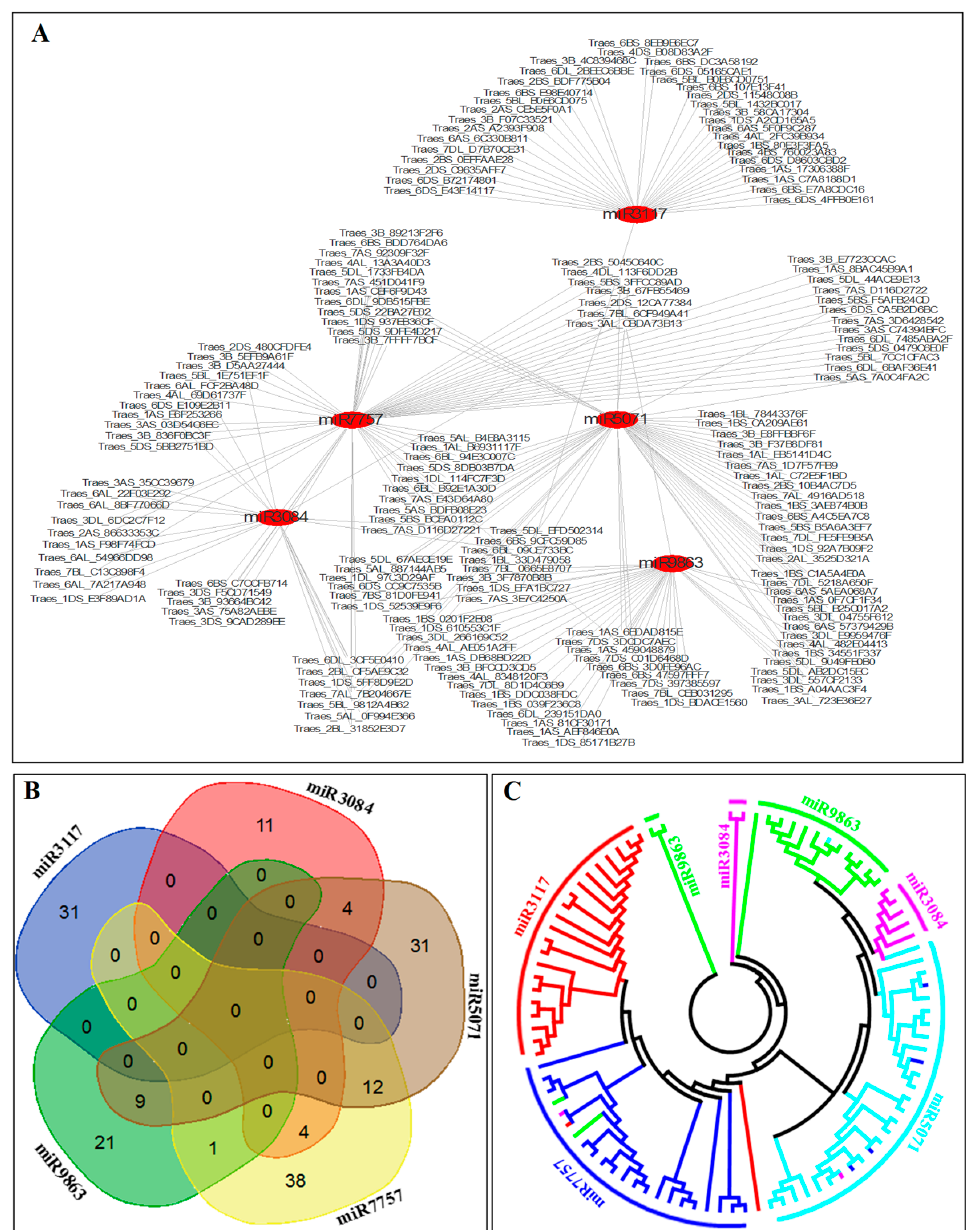
Figure 7. ( A ) The posttranscriptional regulation network between the miRNAs and their targets. The ( B ) Venn diagram and ( C ) phylogenetic relationship tree for the target genes of disease resistance-associated